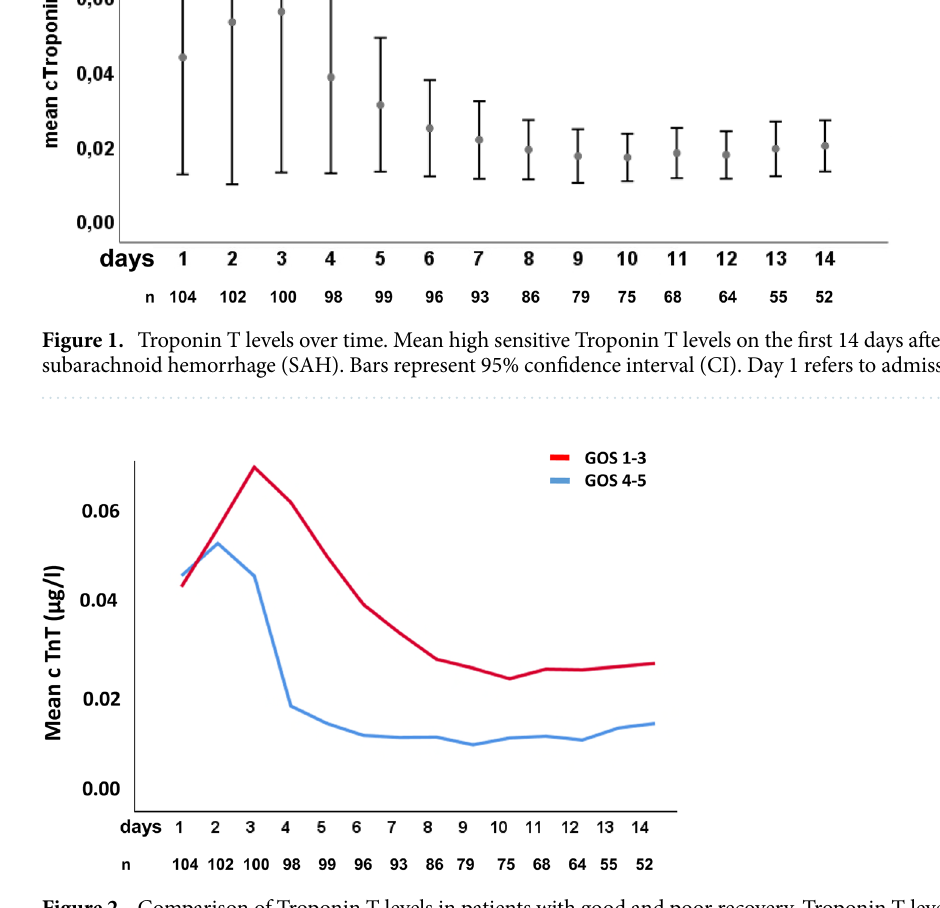
Figure 2. Comparison of Troponin T levels in patients with good and poor recovery. Troponin T levels were significantly higher from admission for further 14 days in patients with moderate to poor recovery (GOS1–3) than in patients with good recovery (GOS4–5), p <